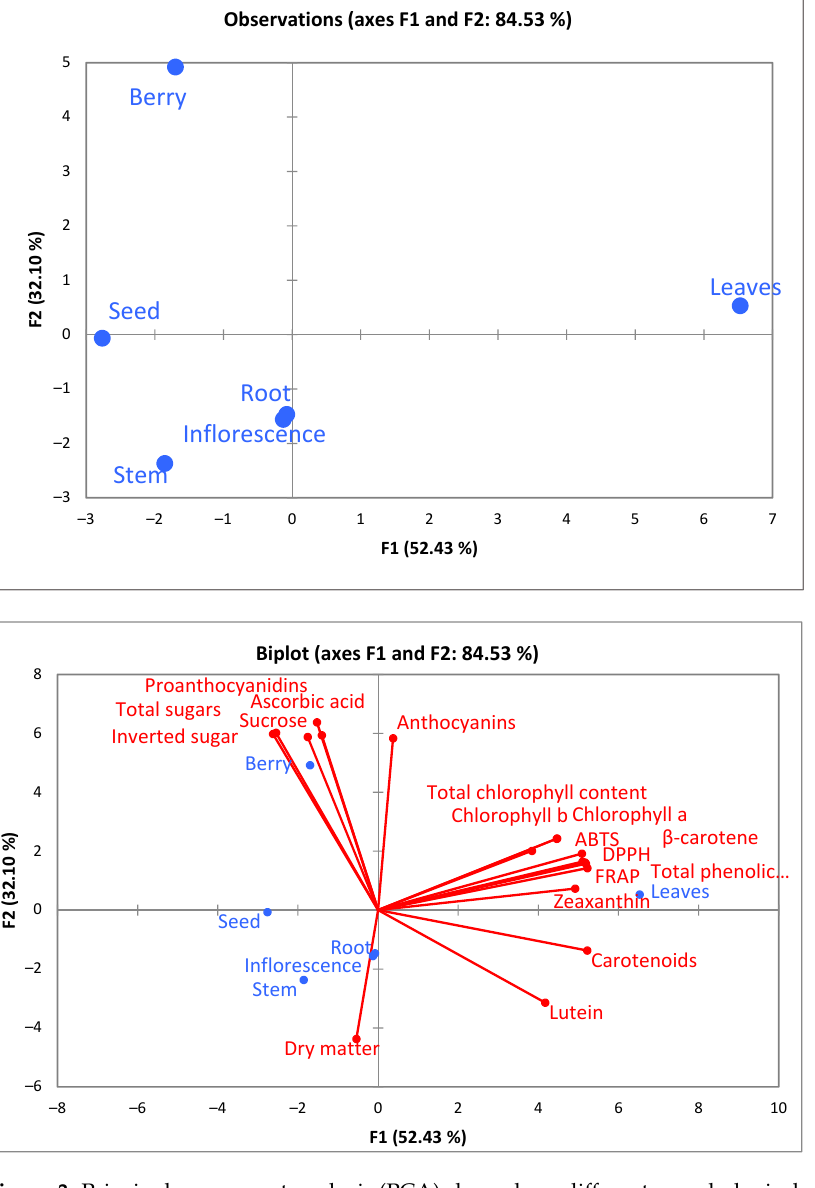
Figure 3. Principal component analysis (PCA) shows how different morphological parts differ from each other by their biochemical composition.